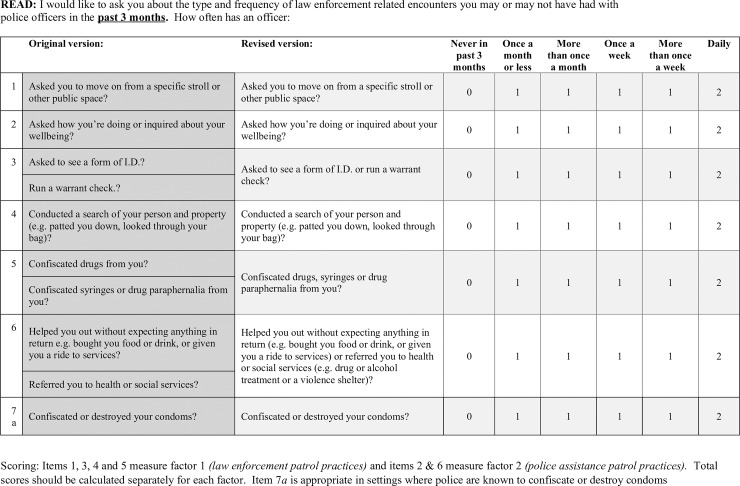
Police Patrol Practices Scale (PPS).Items included in the box were read to participants after the phrase “: I would like to ask you about the type and frequency of law enforcement related encounters you may or may not have had with police officers in the
past 3 months. How often has an officer…[insert item]?” Scoring is shown for original and revised scales. Items 1, 3, 4 and 5 measure factor 1 (law enforcement patrol practices) and items 2 & 6 measure factor 2 (police assistance patrol practices). Total scores should be calculated separately for each factor. Item 7a is appropriate in settings where police are known to confiscate or destroy condoms.